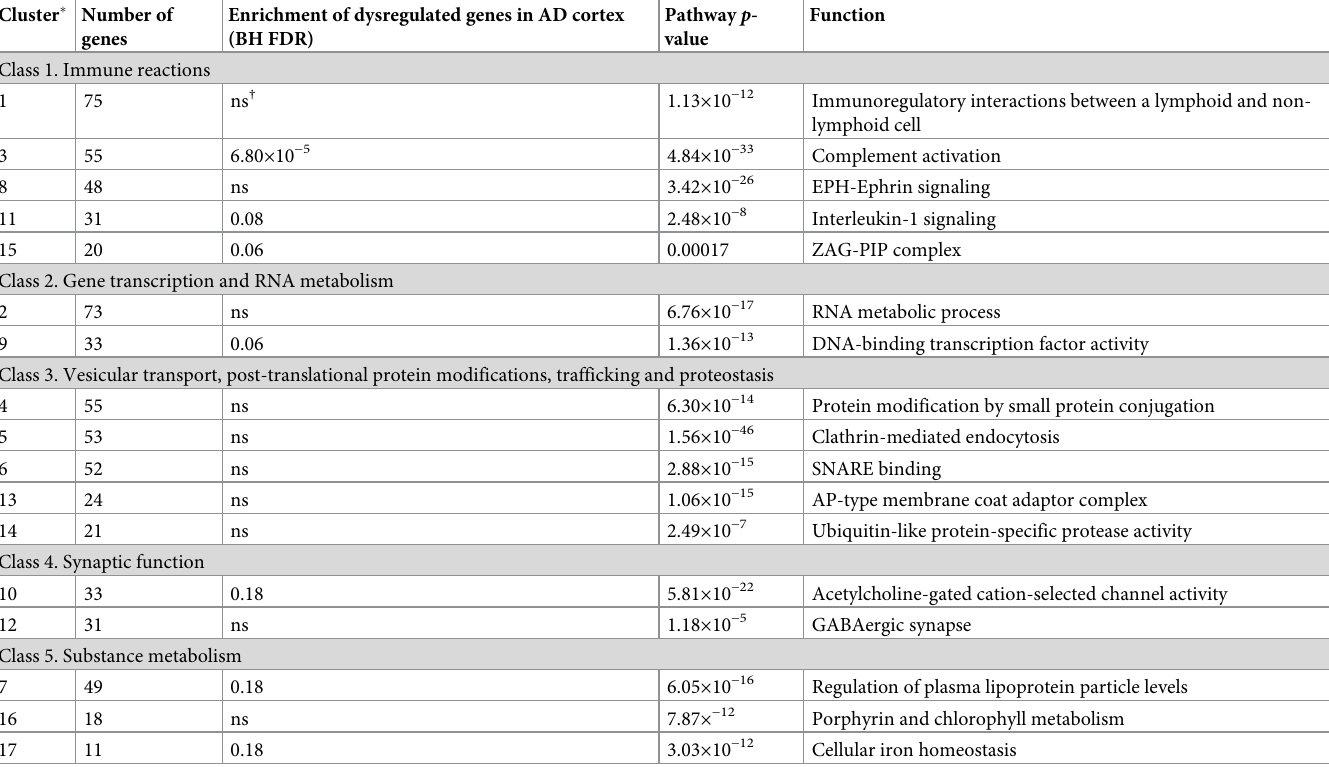
Table 1. Clusters in the expanded AD disease